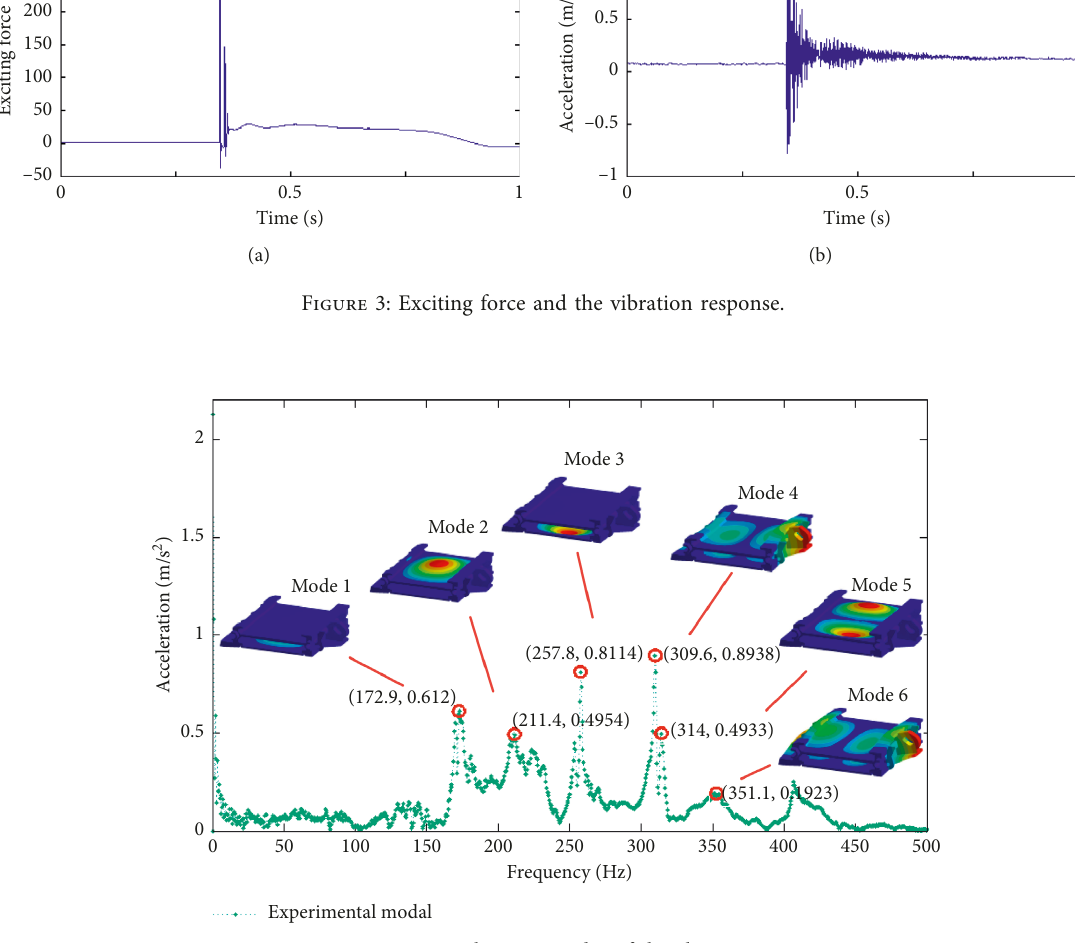
Figure 4: Vibration modes of the